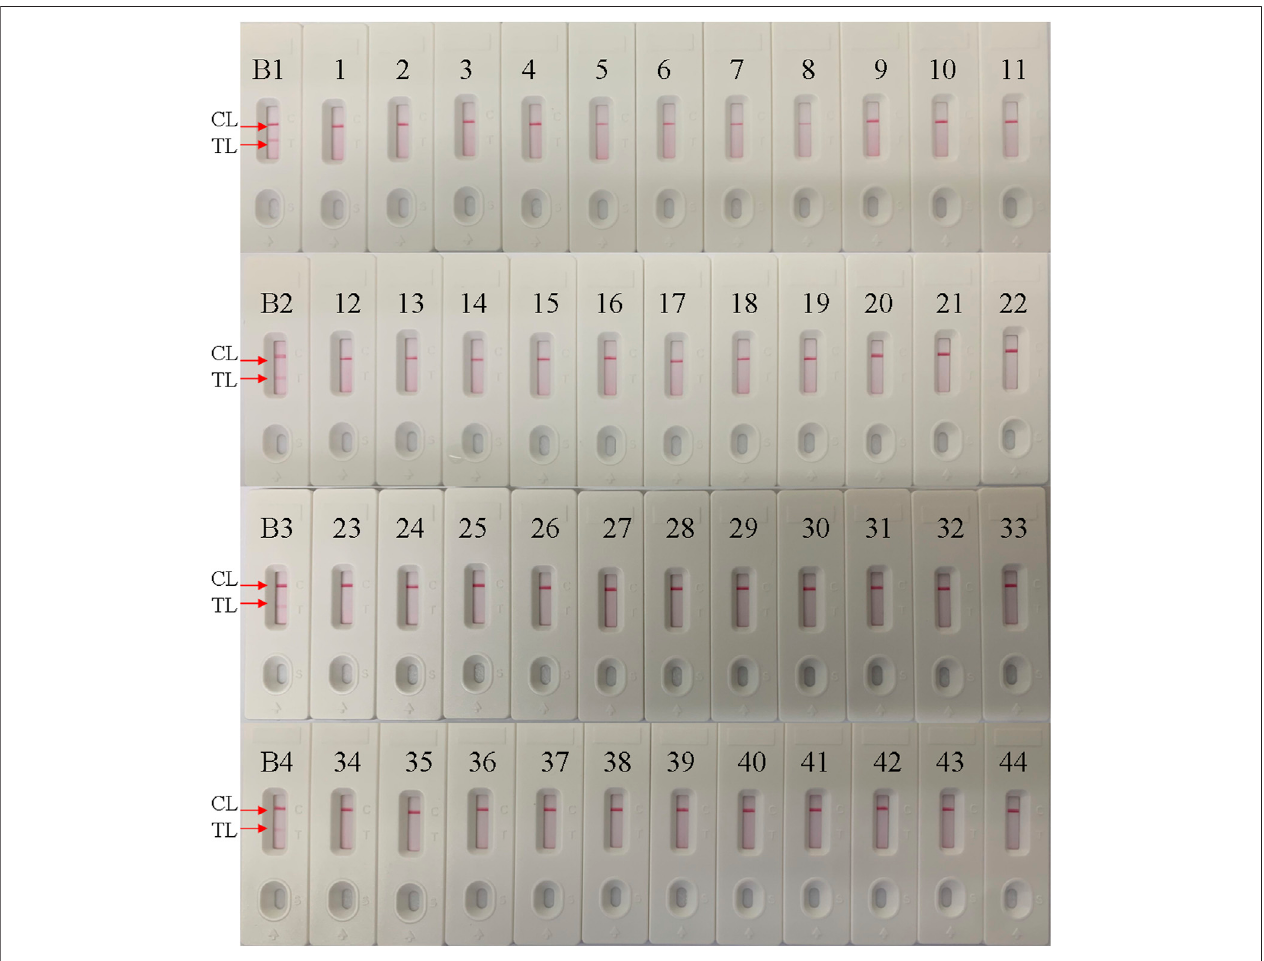
FIGURE 6| Speci fi city conformation for the Bordetella pertussis loop-mediated isothermal ampli fi cation (LAMP) assay. Alateral fl ow biosensor was applied for the LAMP products. Strips B1 – B4 represent DNA isolation of the B. pertussis -positive clinical samples; strips 1 – 44 represent the other bacterial strains, shown in Table 2 . TL , test line; CL , control